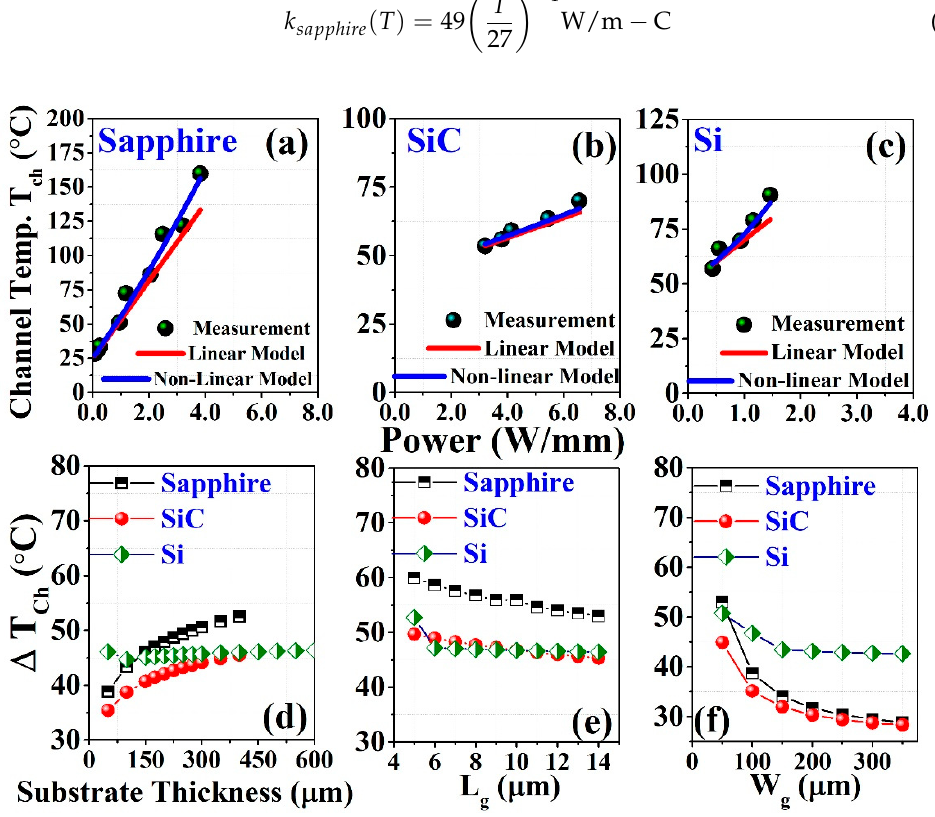
Figure 5. Thermal resistance measurement and the linear and non-linear model of ( a ) sapphire, ( b ) SiC, and ( c ) Si. Thermal resistance dependence of substrate thickness ( d ), gate length ( e ), and gate width ( f ). Table 1. Calculation of linear and non-linear channel temperature (sapphire